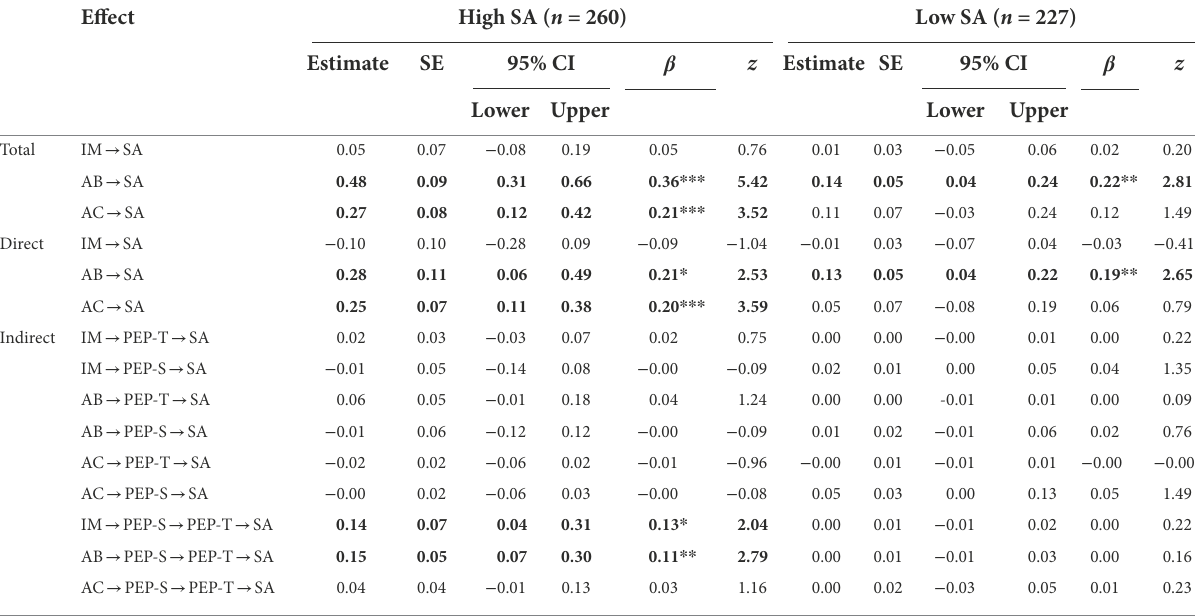
TABLE 4 Total, direct, and indirect effects on the relationship between the subtypes of safety behaviors and social anxiety.